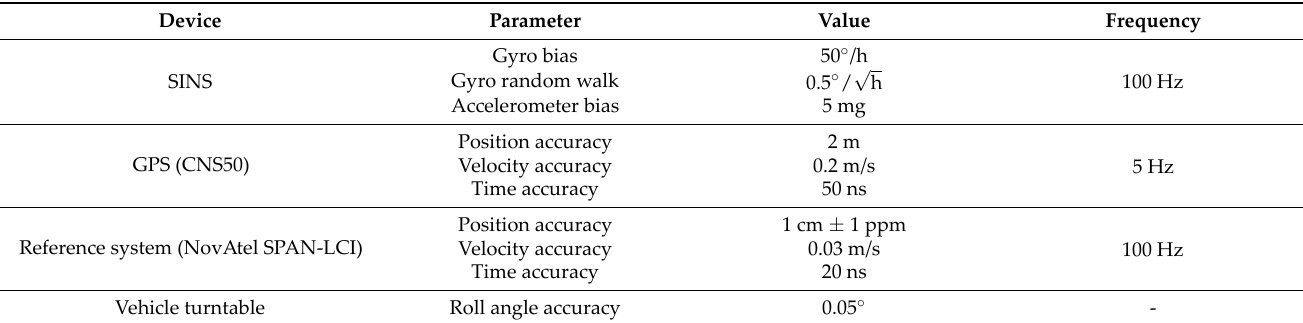
Table 1. Parameters of relevant devices.